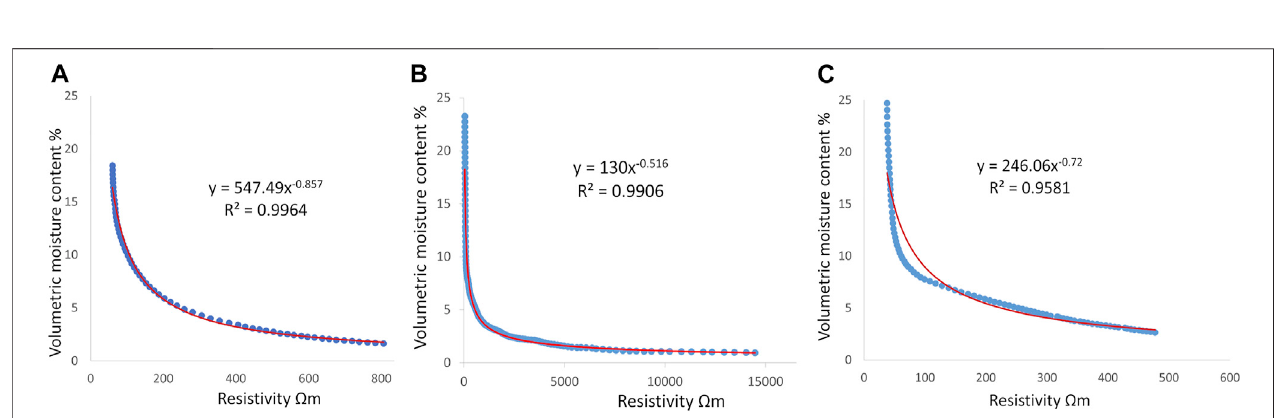
FIGURE3| Power-lawrelationshipsbetweenvolumetricmoisturecontent(%)andelectricalresistivity( Ω m)forallthedepthsofMooribinsite (A) andKukerinsitefor lower inverted EC range of 0 – 12 mS m − 1 (B) and higher inverted EC range of 12 – 36 mS m − 1 (C) . The red line is the fi tted power-law.